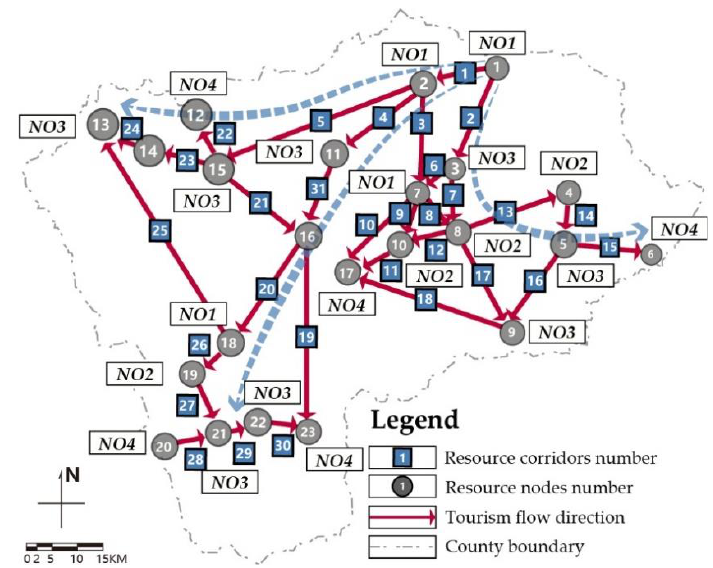
Figure 9. Tourism flow direction.